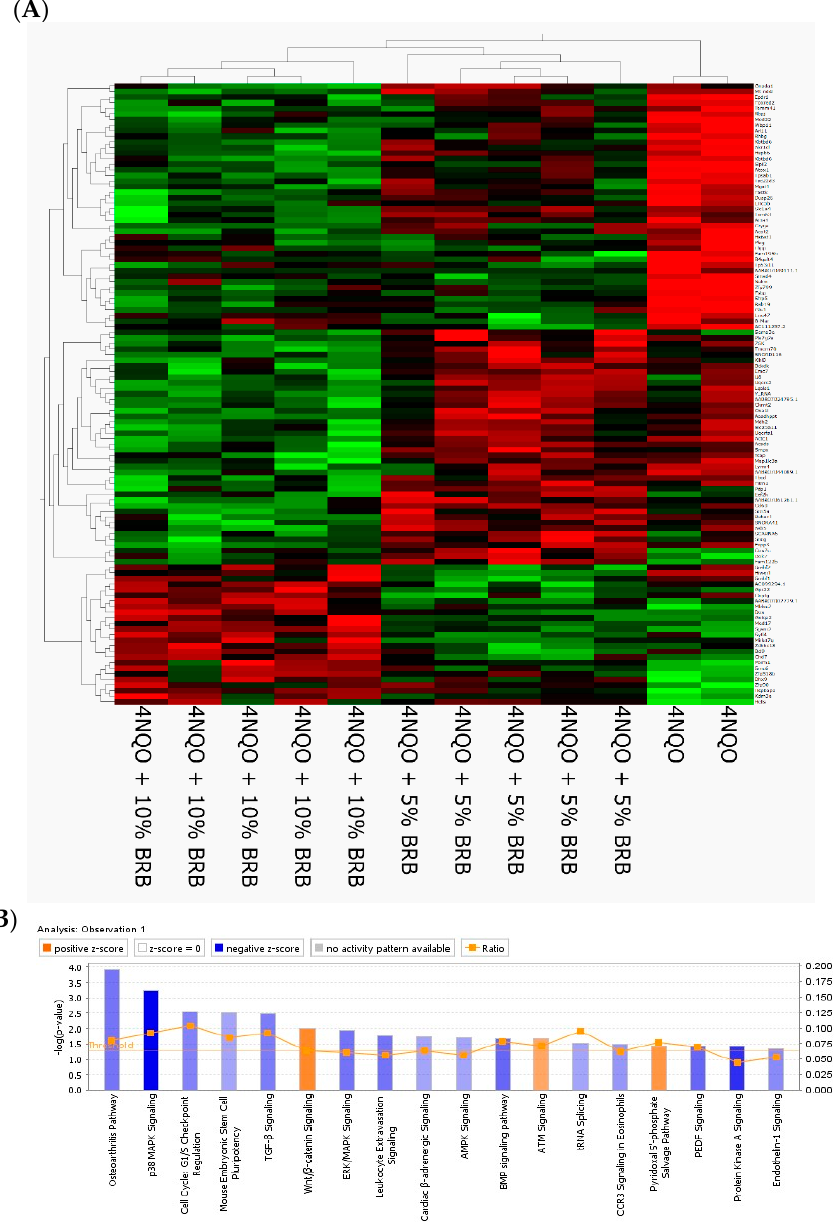
Figure 2. Modulation of global transcriptional profiles during oral cancer chemoprevention by BRBs ( A ) Heat map showing differentially expressed genes from rat tongues during 4NQO induced oral carcinogenesis and BRB mediated oral cancer chemoprevention. 4NQO exposed rats were fed a control diet, 5% BRB, or 10% BRB supplemented diet. ( B ) Ingenuity pathway analysis of the canonical transcriptional pathways modulated by dietary BRB intervention during oral carcinogenesis. Transformed RNA sequencing data from rat tongue RNA from 4NQO exposed, BRB treated, and untreated rat groups were analyzed using Ingenuity Pathway Analysis software